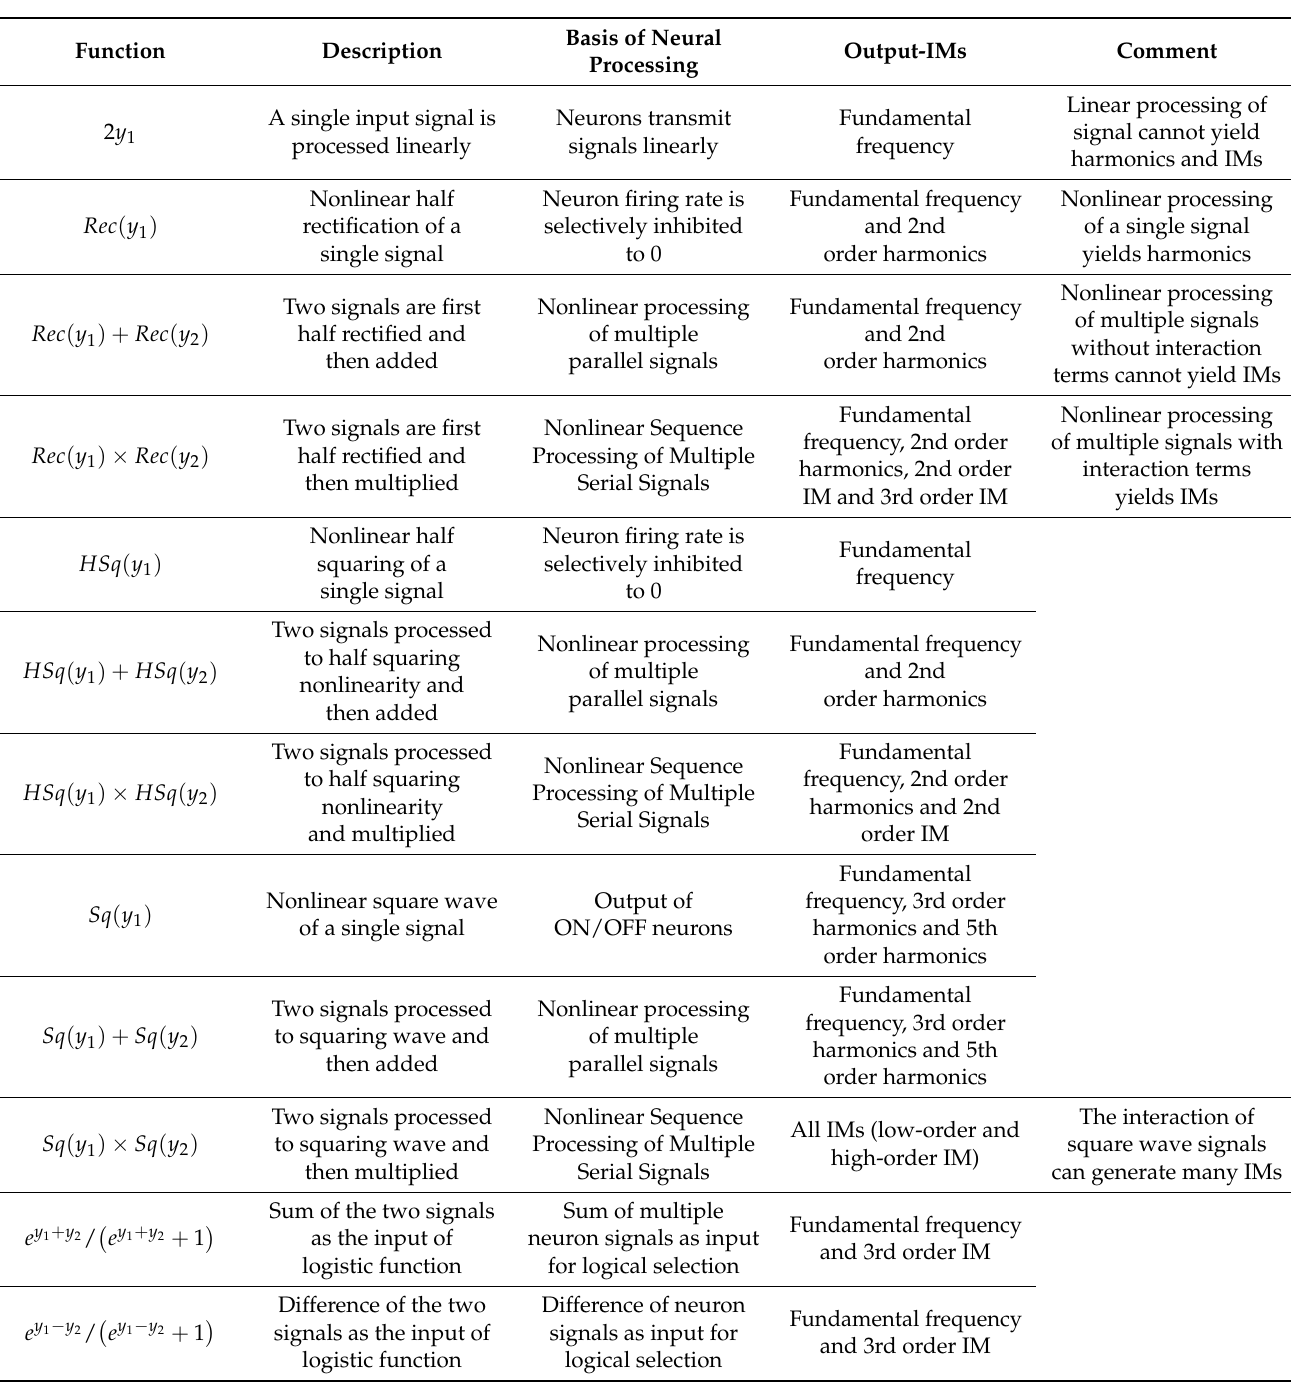
Table 1. Different mathematical formulae and their